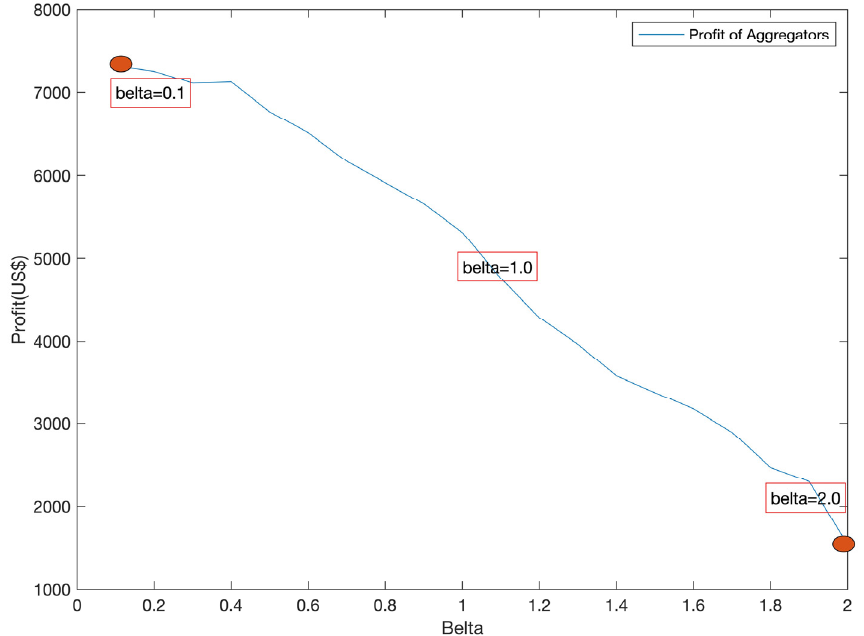
Figure 9. The profit of aggregators with the influence by risk aversion